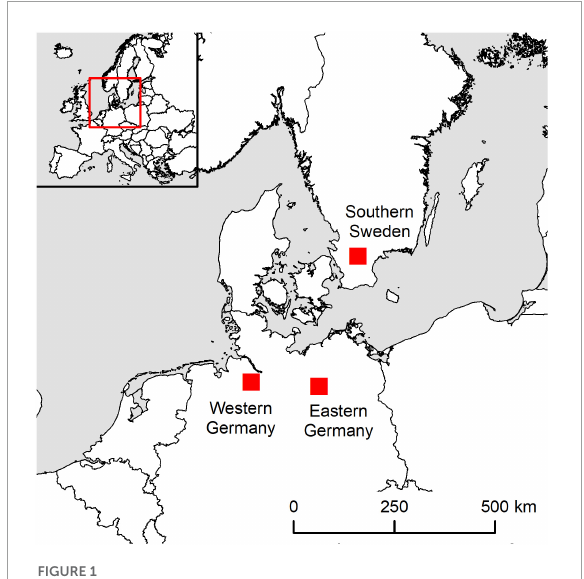
FIGURE1 Locations of landscape windows (red squares) in Germany and